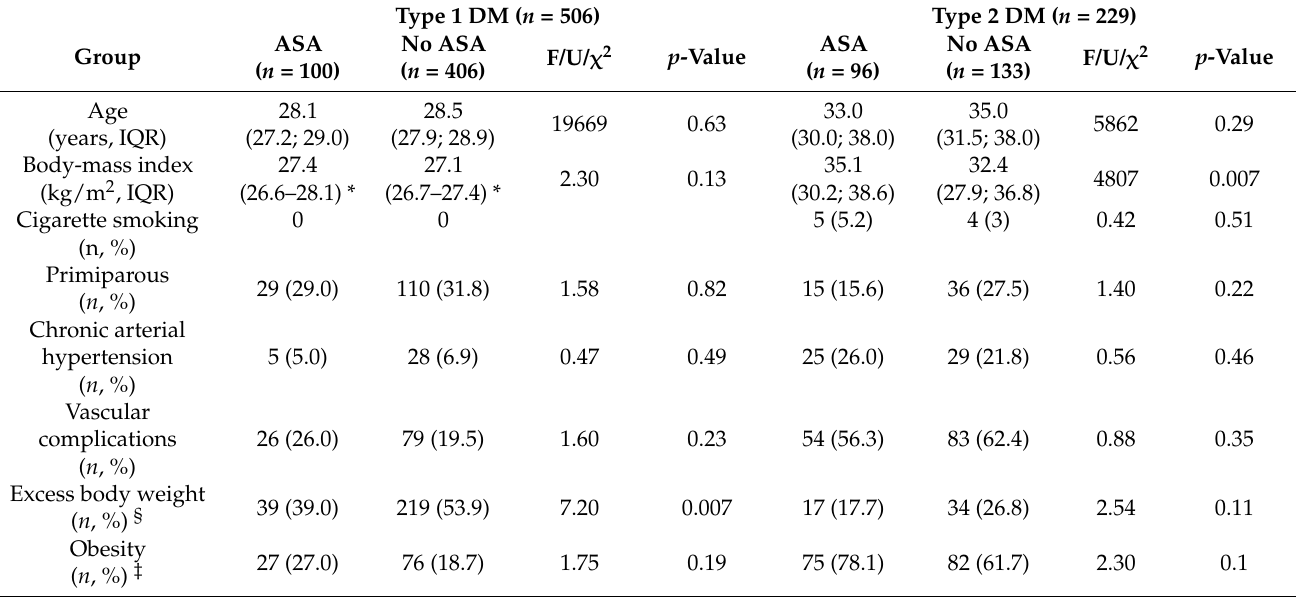
Table 1. Clinical characteristics of the study